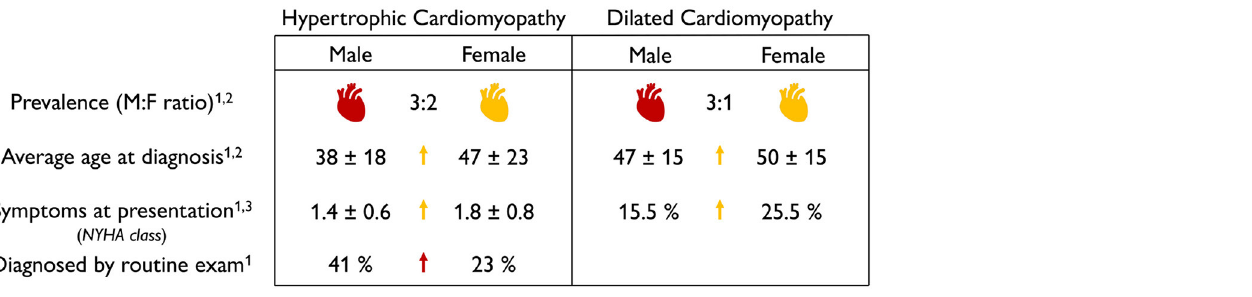
TABLE 8 | Sex differences in pathological adaptation.